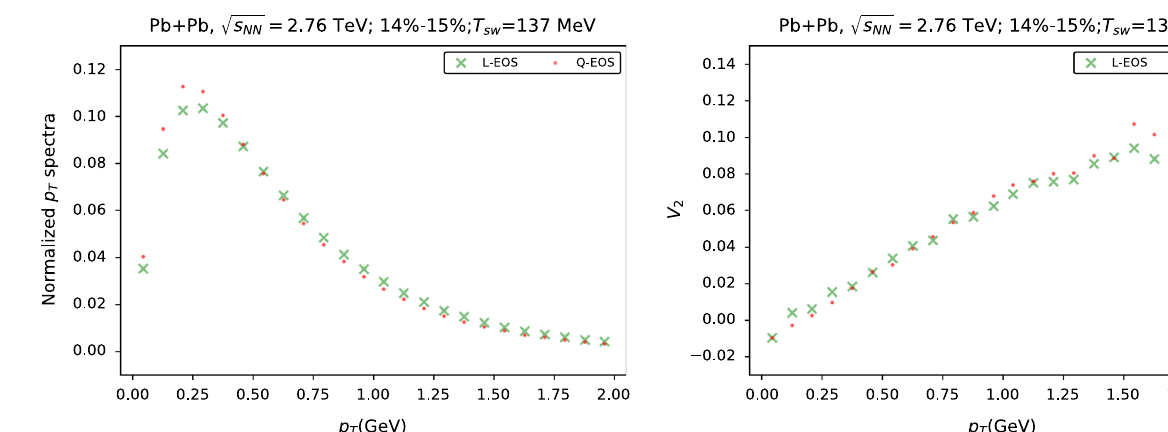
in Tables 1 and 2 with two EoSs. The green cross and the red point symbol depict the observables with L-EOS and Q-EOS, respectively. These events are generated in different centrality bins with T s w = 137 MeV in two collision